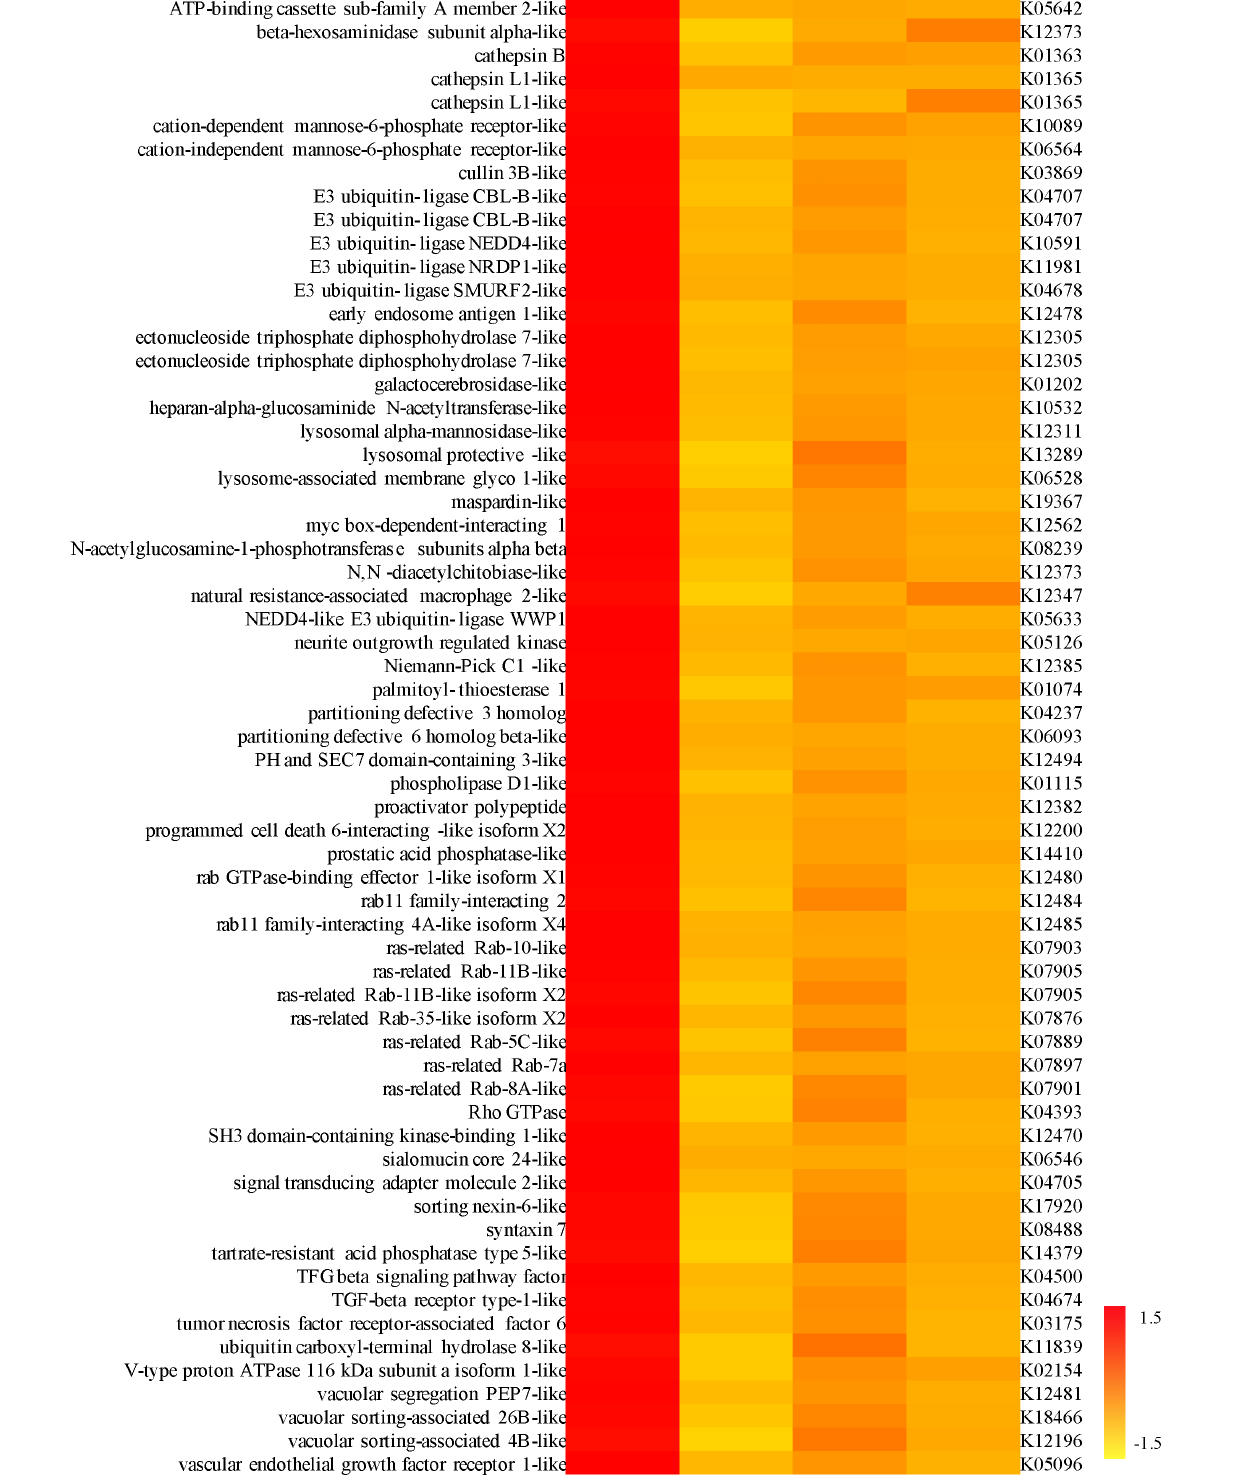
Frontiers in Marine Science |